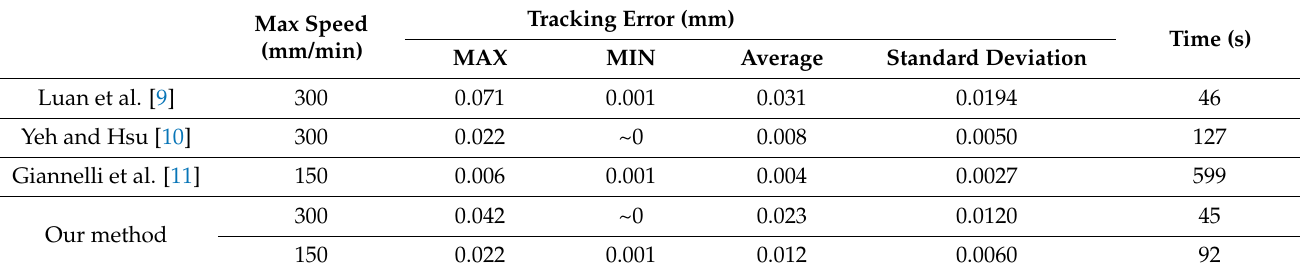
Figure 23. Jerk when cutting trident shape using ( a ) method by Luan et al. [9], ( b ) method by Yeh and Hsu [10], ( c ) our method with maximum feed rate of 150 m/min, and ( d ) our method with maximum feed rate of 300 mm/min. Table 8. Tracking error and processing time for trident